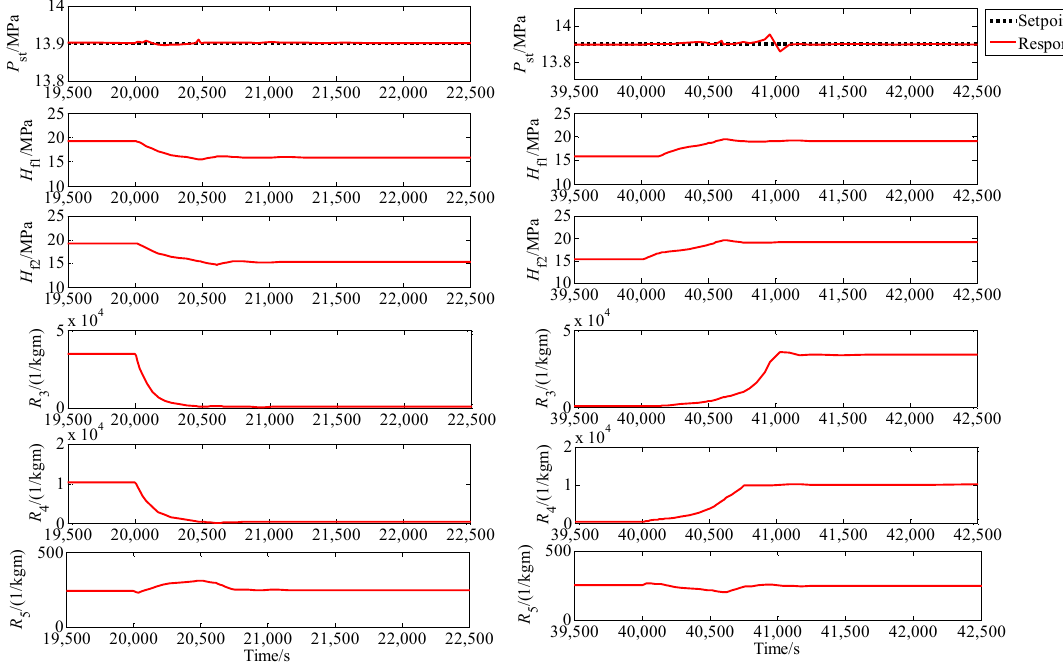
Figure 14. Responses of main steam pressure, feedwater header and branch resistances, P st : main steam pressure, H f1 and H f2 : header given by 1# and 2# feedwater pump, R i : fluid resistances in branch i ( i = 3, 4, 5).